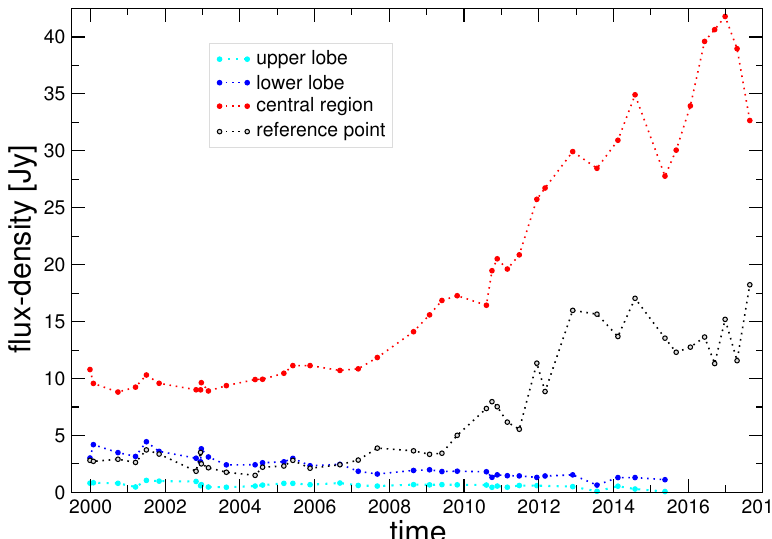
Figure 7. The flux-densities of the upper lobe, lower lobe, central region, and the reference component. The flux density of the central region is the brightest part of 3C